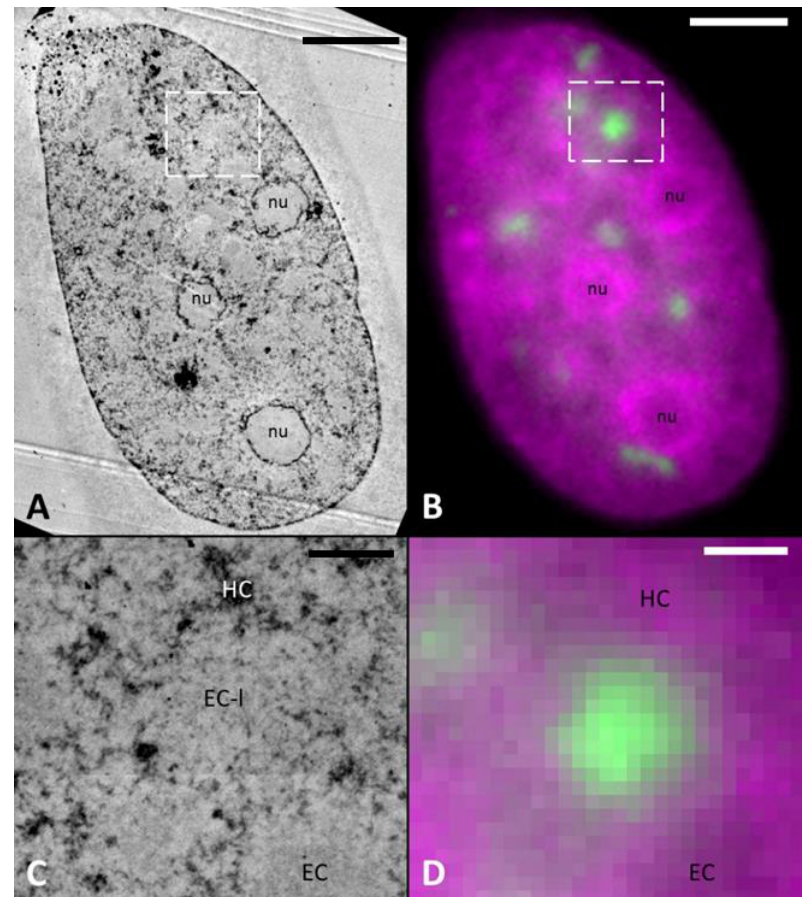
Figure 4. DNA-specific contrasting with osmium ammine B (OA-B). TEM image of OA-B stained sample ( A ). ( B ) Shows the same cell in fluorescence microscopy (53BP1 (green) and DNA (magenta)). Similar to ChromEMT stained sample (Figure 3) no LDA phenotype is visible. 53BP1 focus ( D , green) correlates to a EC-like (EC-l) structure ( C ) and shows a similar DNA density to regular EC. Scale bar: A & B 5 µm, C & D 1µm.